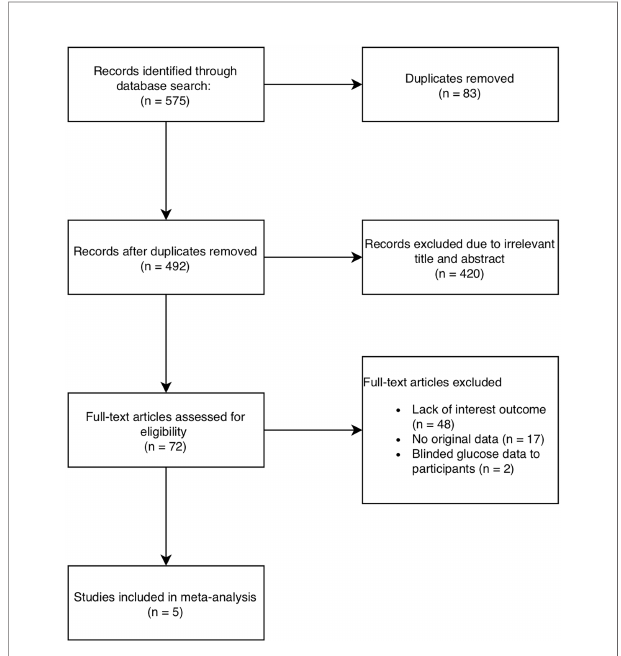
FIGURE 1 | Flowchart of study diagram according to PRISMA